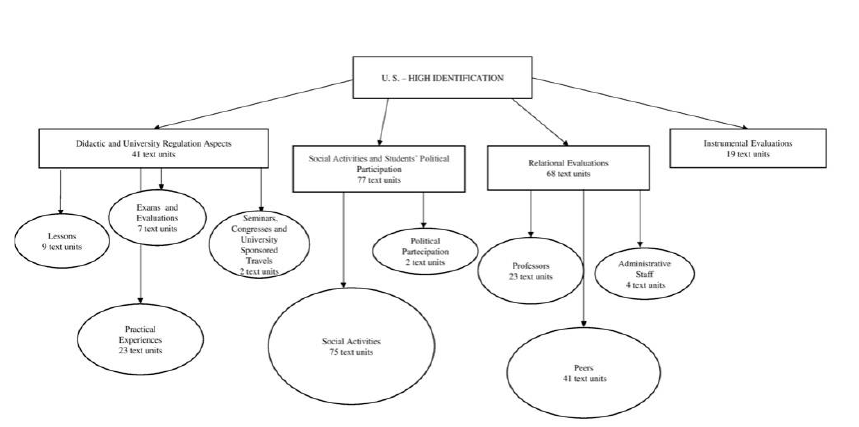
N = 115; text units =